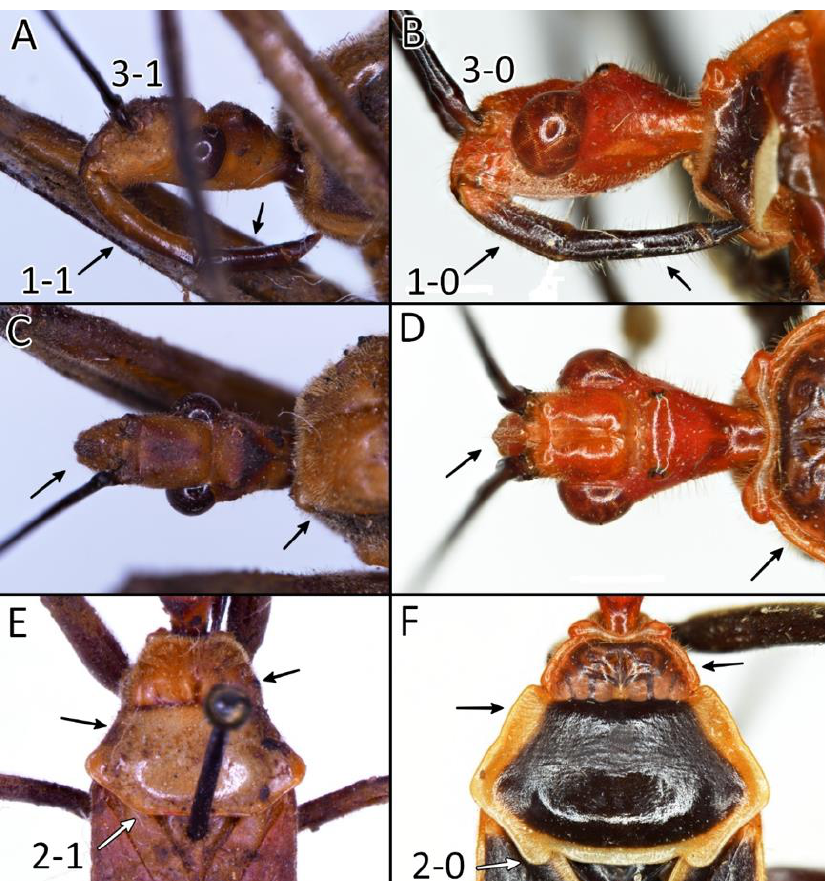
Figure 3. Comparison of the distinctive characters of representatives of the genera Pseudophonoctonus Schouteden, 1913 ( Pseudophonoctonus sp. at A , C , E ) and Phonoctonus Stål, 1853 ( P. fairmairei Villiers, 1948 at B , D , F ). ( A , B ) head in lateral view; ( C , D ) head in dorsal view; ( E , F ) anterior and posterior pronotal lobes. The arrows indicate the features described in the text.